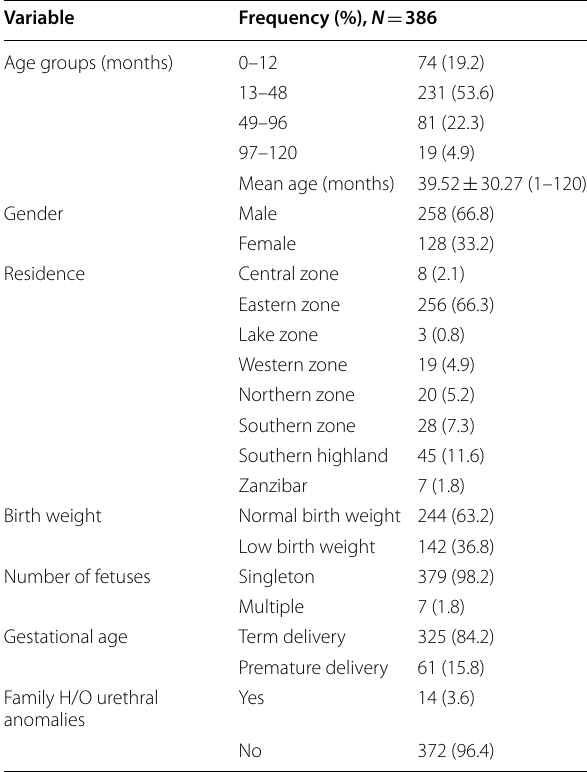
Table 1 Socio-demographic and clinical characteristics of